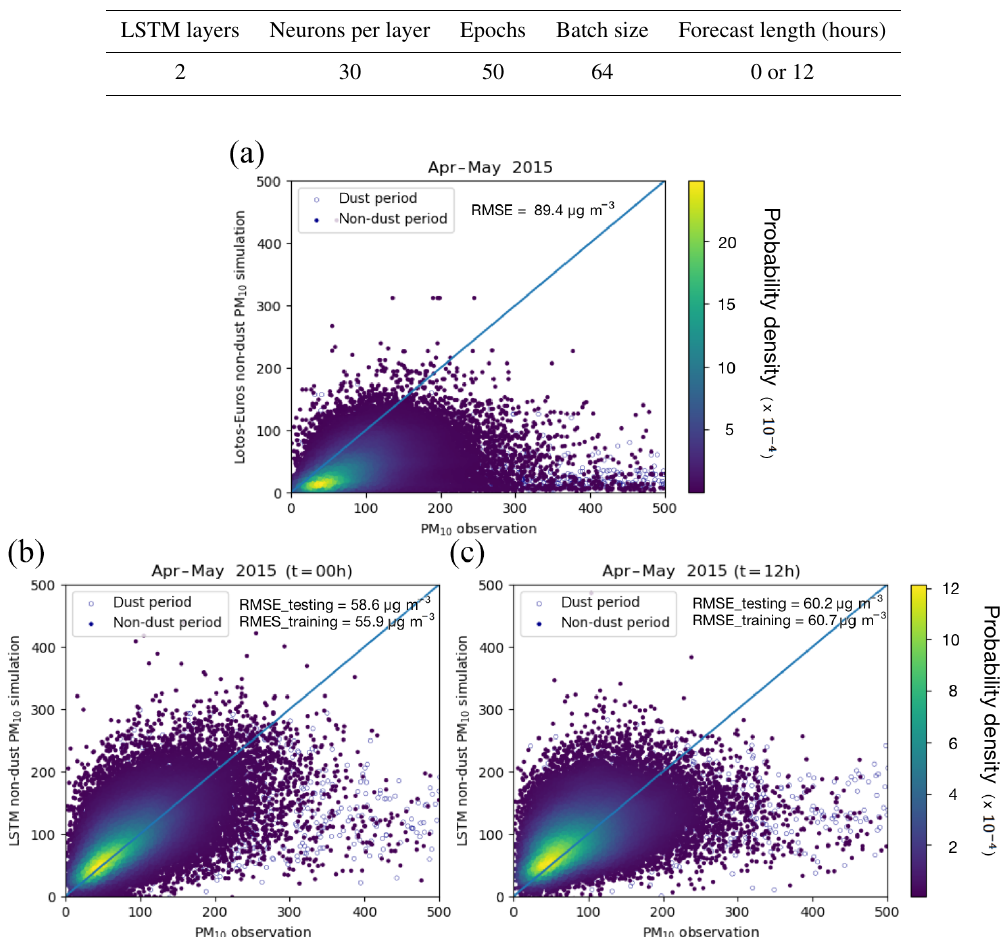
Table 1. LSTM hyper-parameters.